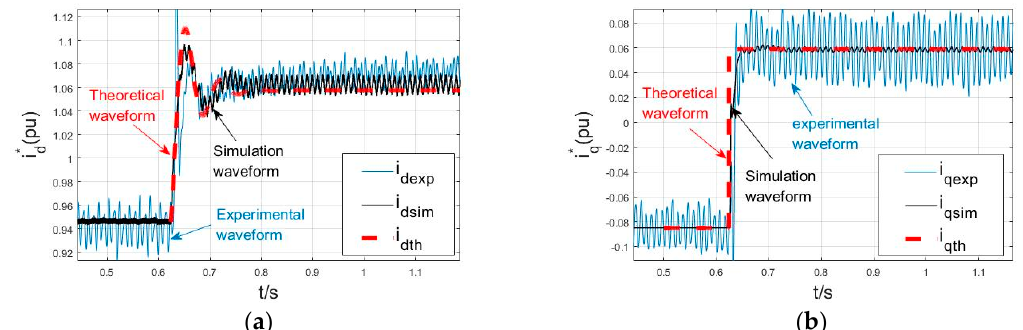
section, the theoretical analytical solution and theoretical waveform of the fault current are calculated.